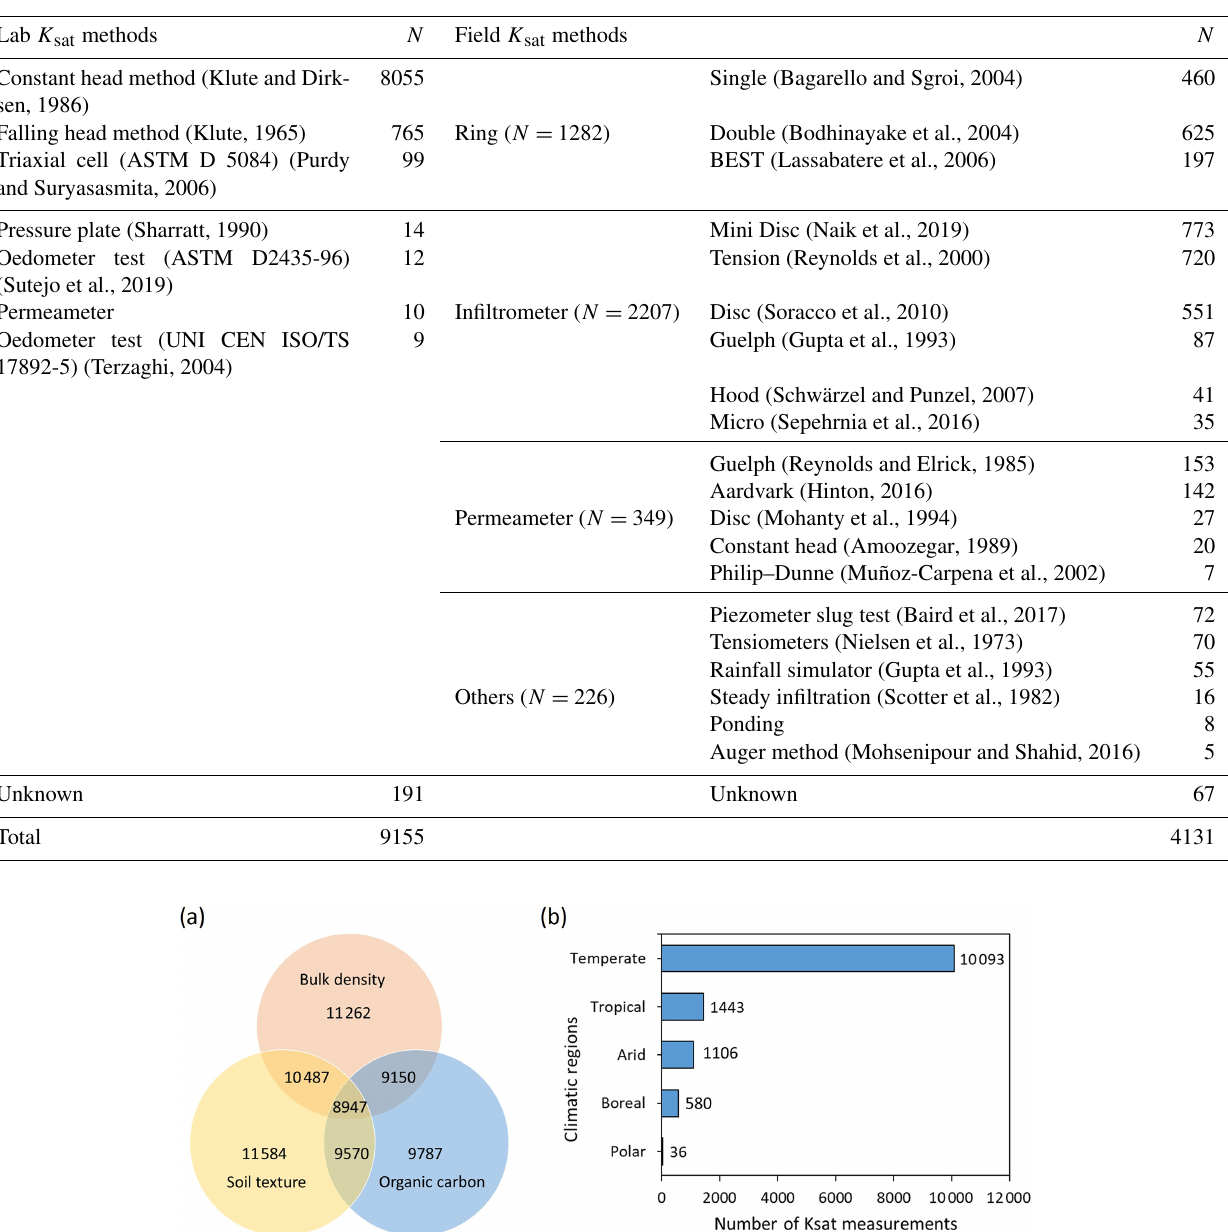
Figure 2. Description of K sat measurements. (a) Venn diagram illustrating the number of K sat measurements in the SoilKsatDB for which bulk density, soil texture, and soil organic carbon data were also available. Note that the size of the intersecting areas does not represent the correct fractions. (b) Distribution of K sat measurements among climatic